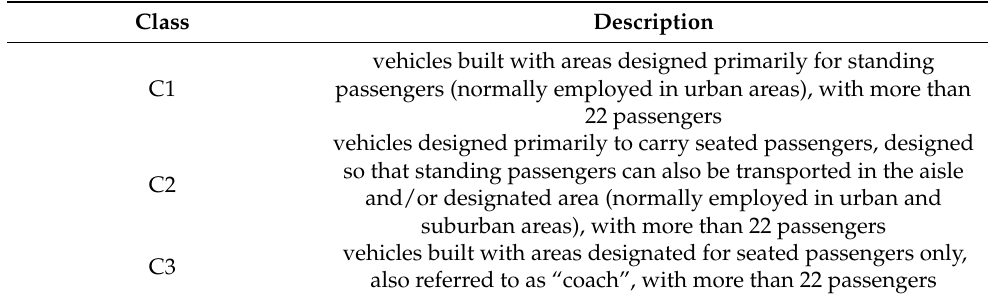
Table 1. Bus classification used in ZEB model